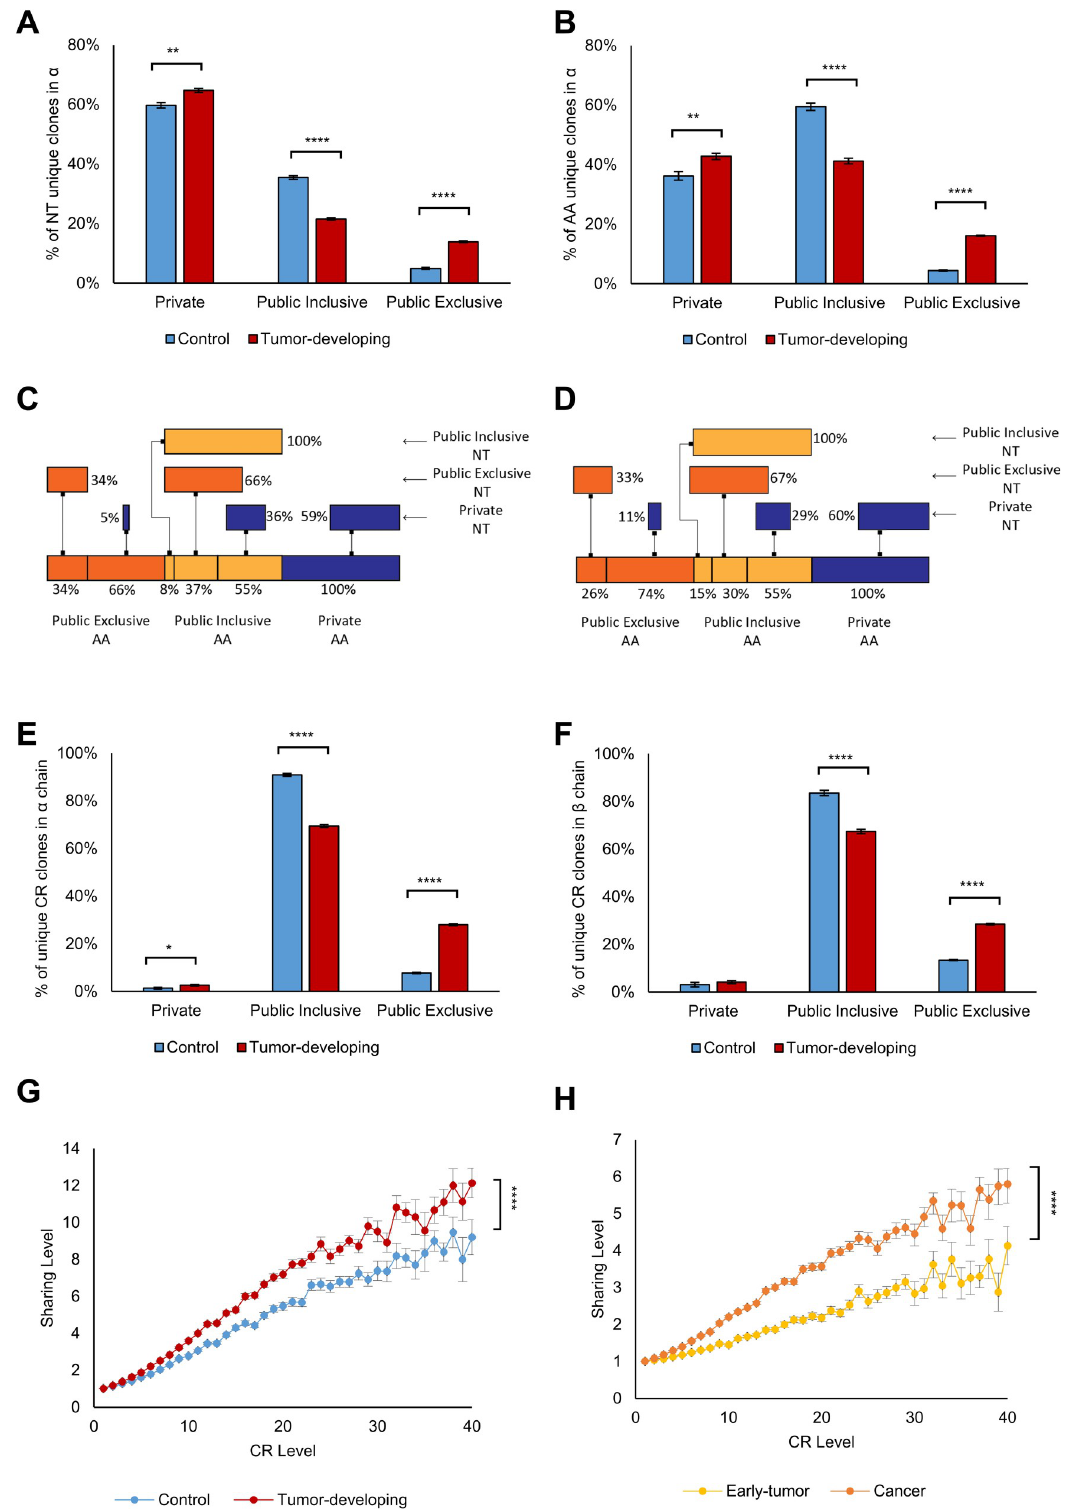
Fig 2. Convergent Recombination Dominates the Public Repertoire and the tumor-developing mice repertoire. Public repertoires and their subtypes are shown in tumor-developing mice and in Control mice using nucleotide sequences (A) and using AA sequences (B) in α chain. The Y-axis in the panels shows the percentages of “unique” clones, where we used the common